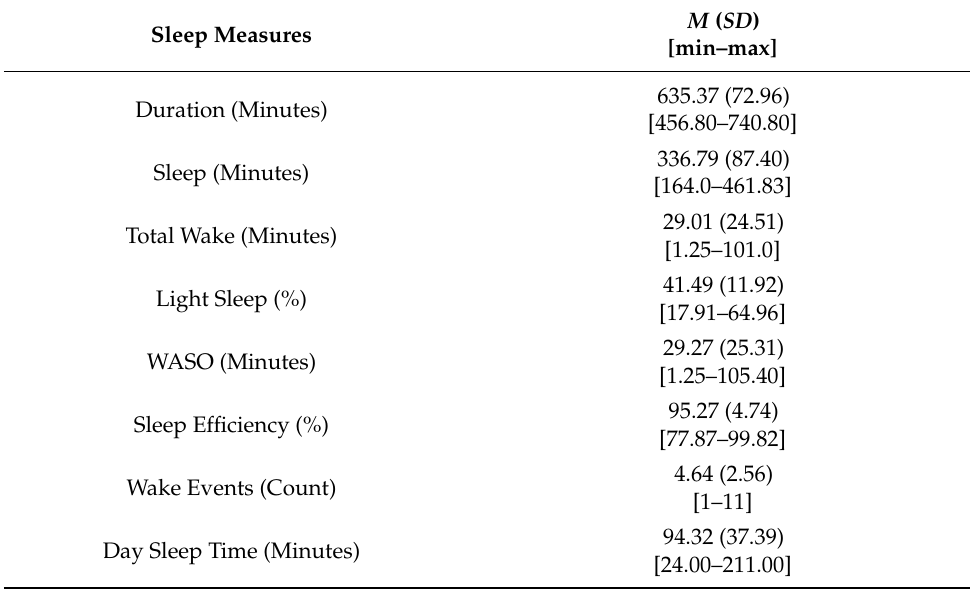
Table 3. Descriptive statistics for sleep